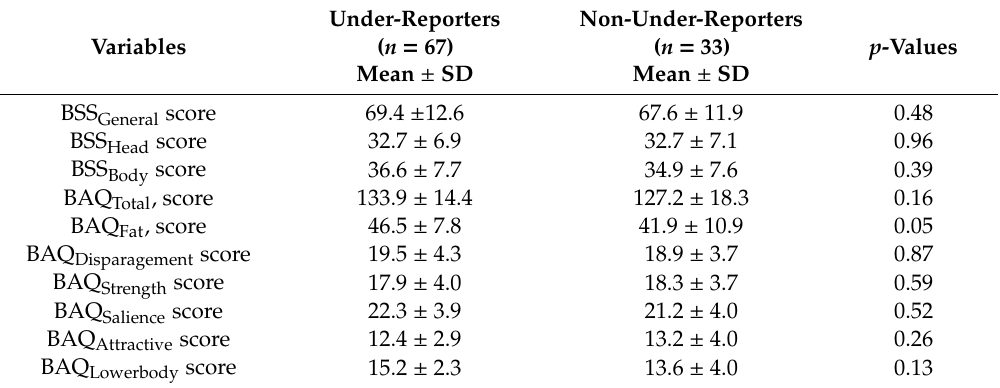
Table 5. Di ff erences in body perception, body dissatisfaction and body concerns between non-under-reporters and suspected under-reporters.